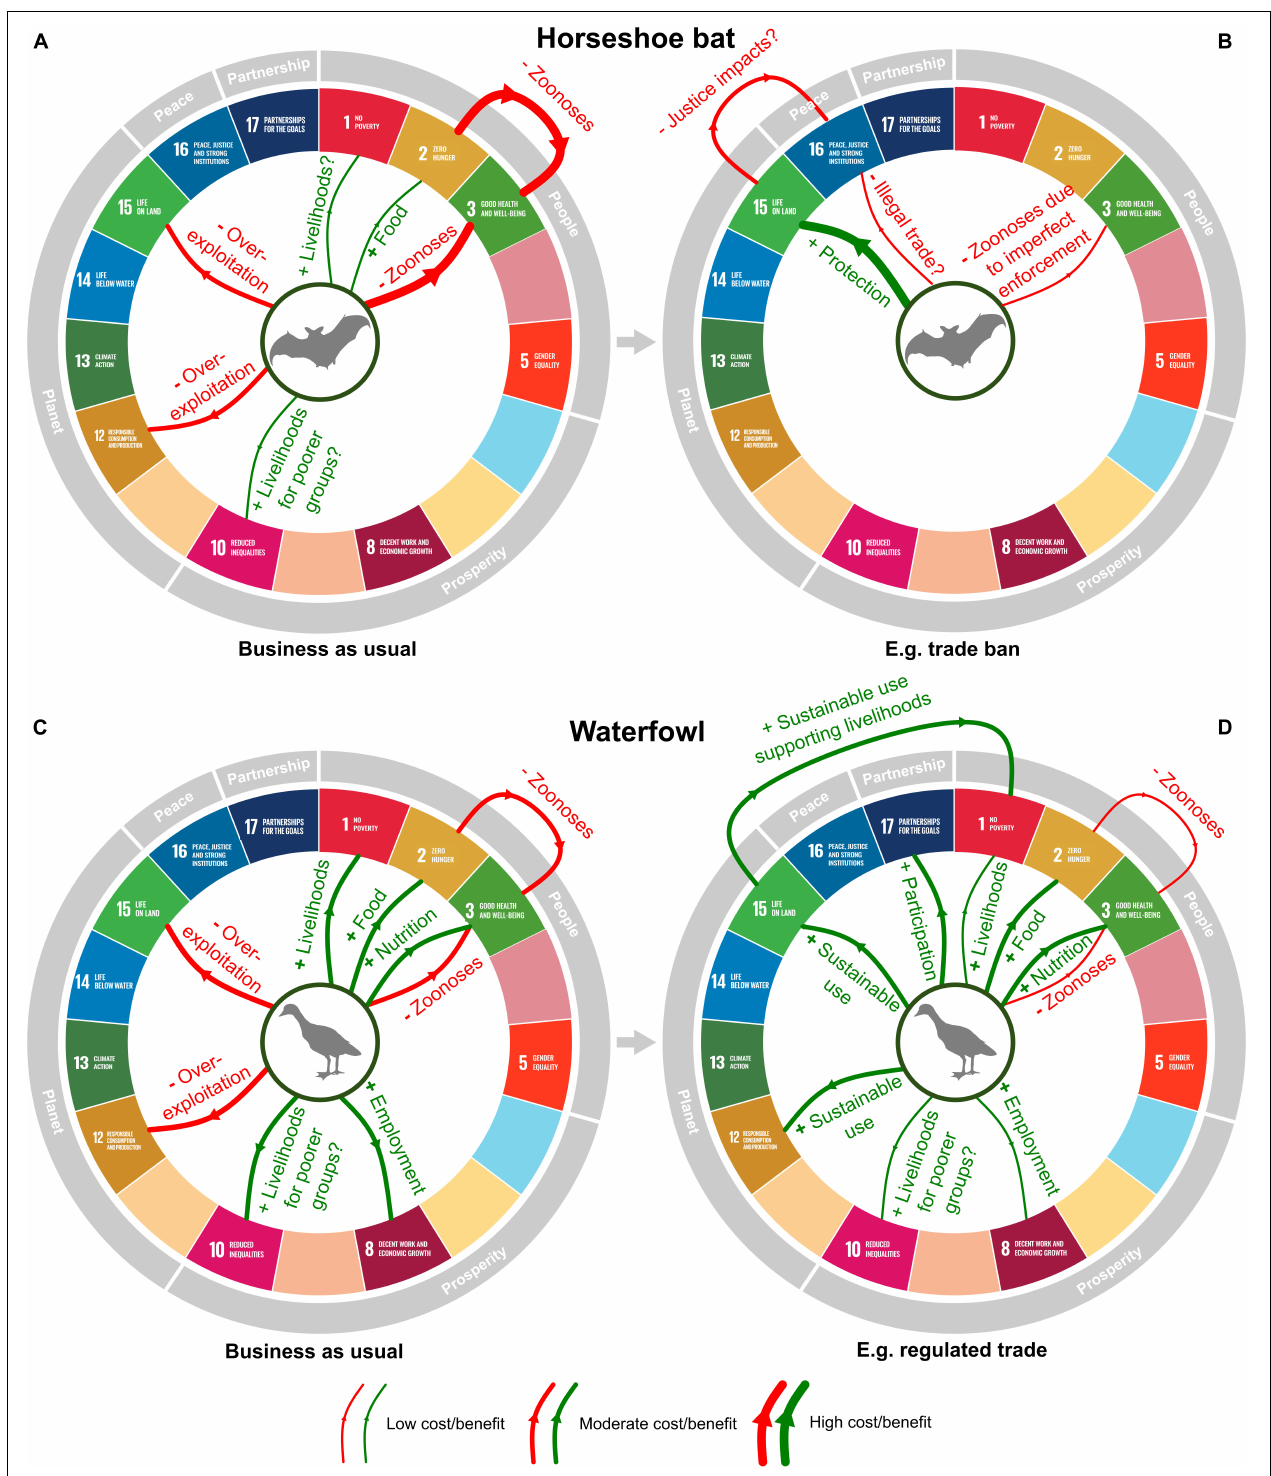
FIGURE 2 | Examples of current positive (green) and negative (red) contributions of horseshoe bat (A) and waterfowl (C) trade to the SDGs, and how context and species-specific policy responses could improve delivery of SDG outcomes (B,D) . Thickness of lines represents the relative size of the costs/benefits, based on the qualitative assessment conducted by the authors in Table 1